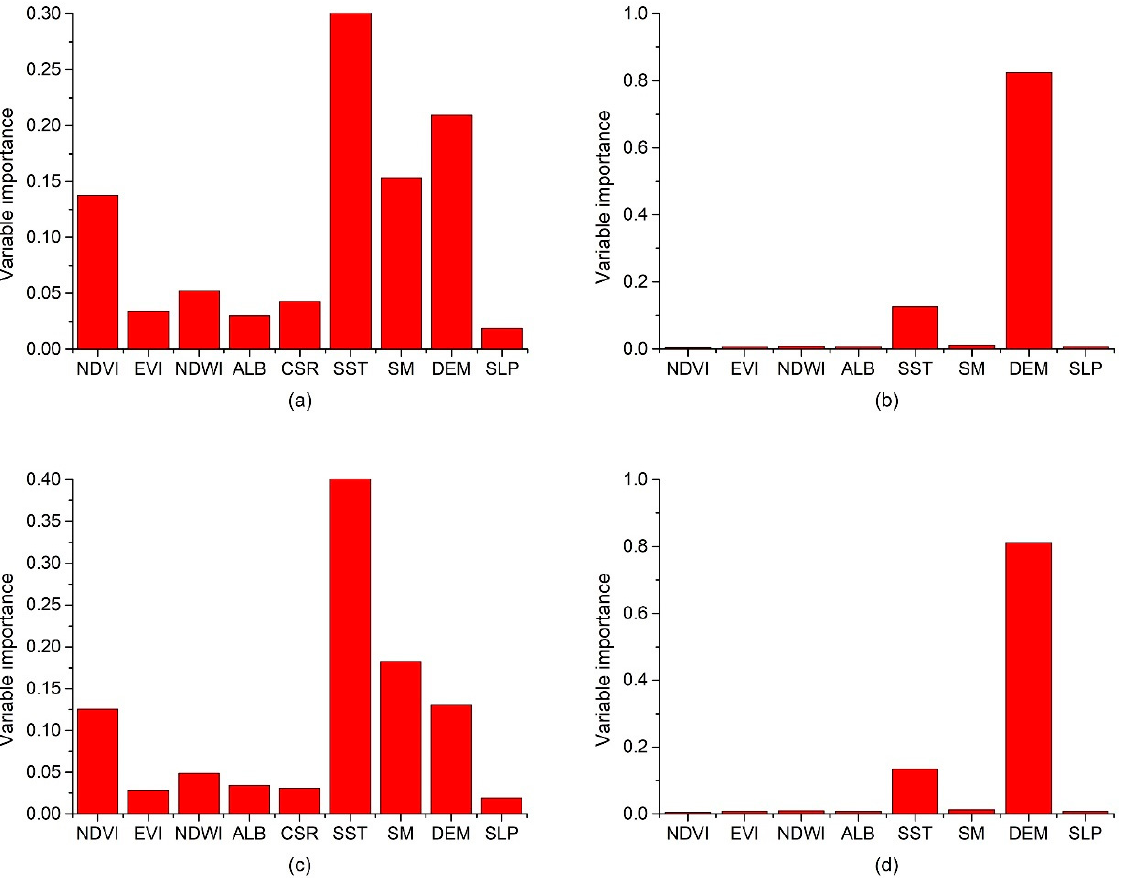
Figure 15. Average importance of each predictor in established XGBoost models for ( a ) MOD11A1 daytime LST; ( b ) MOD11A1 nighttime LST; ( c ) MYD11A1 daytime LST, and ( d ) MYD11A1 nighttime LST during summer time in 2017 and 2018.